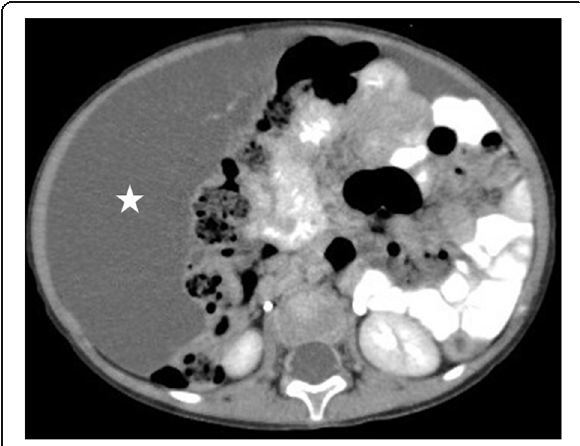
Fig. 30 A 1-year-old male patient presented with progressively enlarging abdominal girth . Axial plane CT image after IV and oral contrast use shows a large purely cystic mass (star), displacing the bowel loops to the left side of the abdomen. Histopathological examination after surgical extirpation confirmed omental lymphangioma